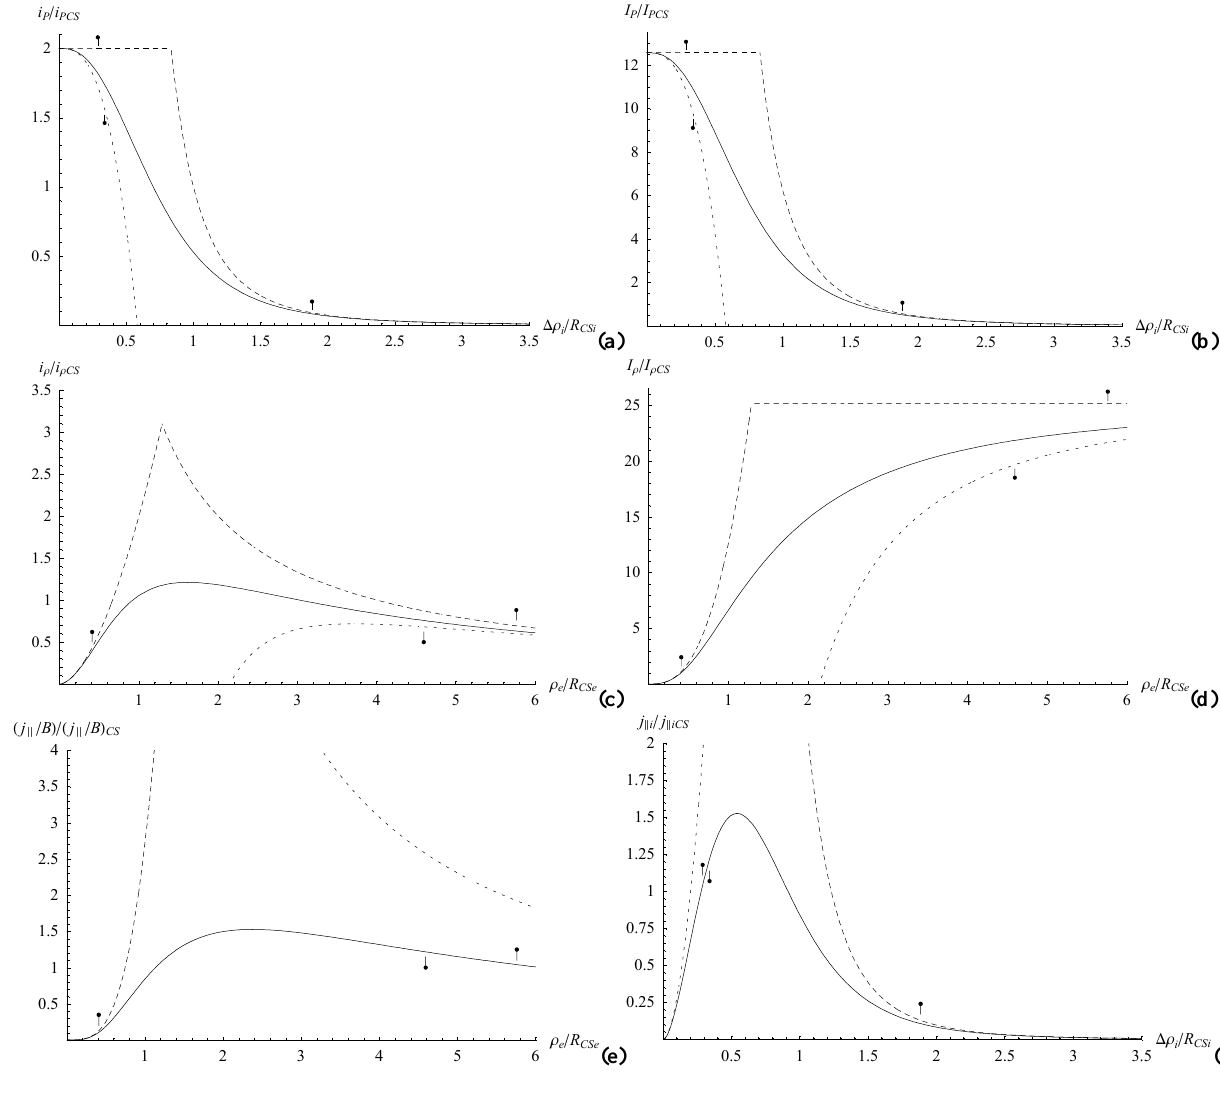
Fig. 7. Plots of normalised steady-state current components for a power law equatorial magnetic field (Eq. (24) with m = 2 . 71) and ‘current sheet’ approximate mapping to the ionosphere, plotted versus (ρ e /R CSe ) or (1ρ i /R CSi ) as appropriate. As in Fig. 3 for the dipole, the plots show (a) the height-integrated ionospheric Pedersen current intensity, (b) the azimuth- and height-integrated total ionospheric Pedersen current, (c) the current sheet-integrated equatorial radial current intensity, (d) the azimuth- and current sheet-integrated total equatorial radial current, (e) the equatorial field- aligned current density per unit magnetic field strength, and (f) the field-aligned current density just above the ionosphere. The normalization constants are given by Eq. (34). The solid lines show the full approximate solutions given by Eqs. (28) and (34), while the long-dashed lines show the small and large- ρ e forms derived from (ω/(cid:127) J ) S given by Eq. (32) and (ω/(cid:127) J ) L = 0, drawn to √ their point of intersection at (ρ e /R CSe ) = m 2 . The downward-pointing tic-marks show the limits of validity of these approximate forms as defined for the dipole case. The short-dashed lines show the higher-order large- ρ e form given by Eq. (33), whose limit of validity is indicated by the upward-pointing tick mark, again defined as for the dipole